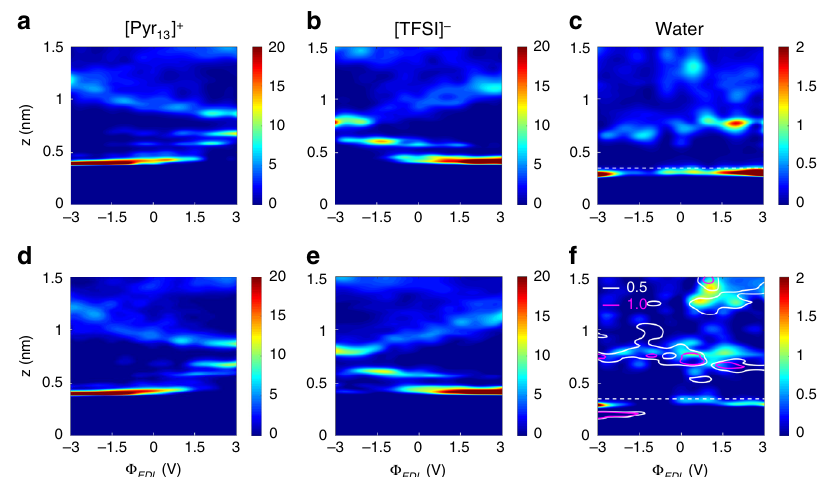
Fig. 1 Ion and water distributions under various potentials. a – c Number densities of cation ( a ), anion ( b ), and water ( c ) in humid 1-methyl-1- propylpyrrolidinium bis(tri fl uoromethylsulfonyl)imide ([Pyr 13 ][TFSI]) as a function of distance from the electrode (z) under various potentials ( Φ EDL ). d – f The number densities of cation ( d ), anion ( e ), and water as well as Li + ( f ), in salt-in-humid [Pyr 13 ][TFSI]. The horizontal dash lines ( z = 0.35 nm) in ( c ) and ( f ) represent the upper boundary of the interfacial region. The contour in ( f ) indicates the number density of Li + ions, and the molar salt – water ratio is 1:1. Unit: # nm − 3